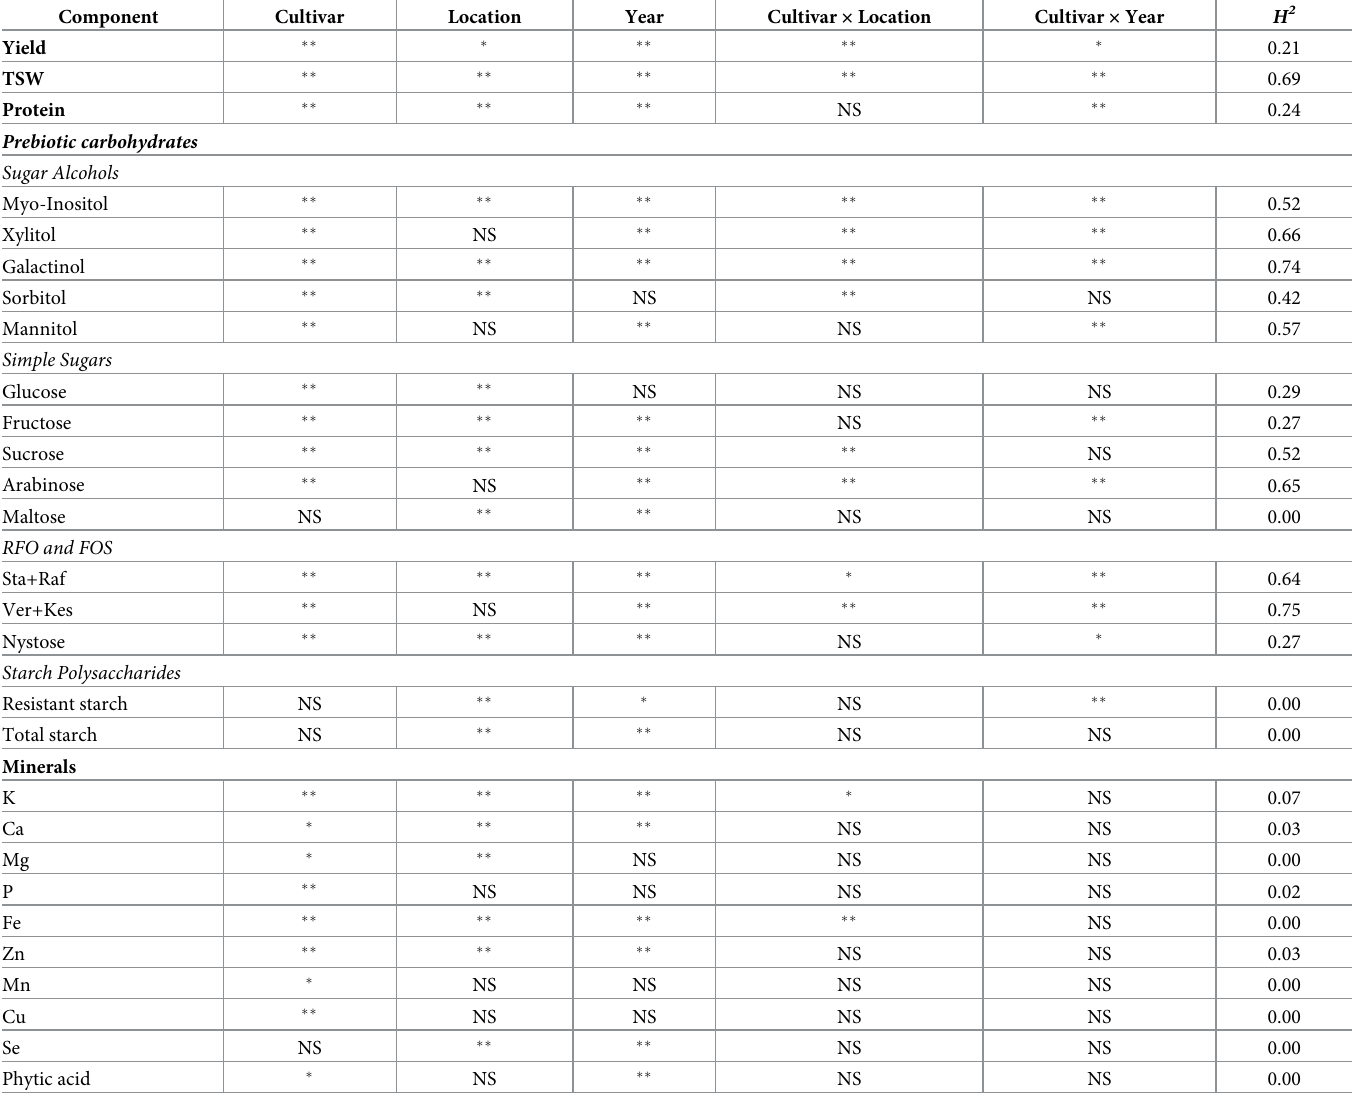
Table 4. Analysis of variance and broad-sense heritability estimates of yield and nutritional traits evaluated for dry pea genotypes tested in SC, USA.